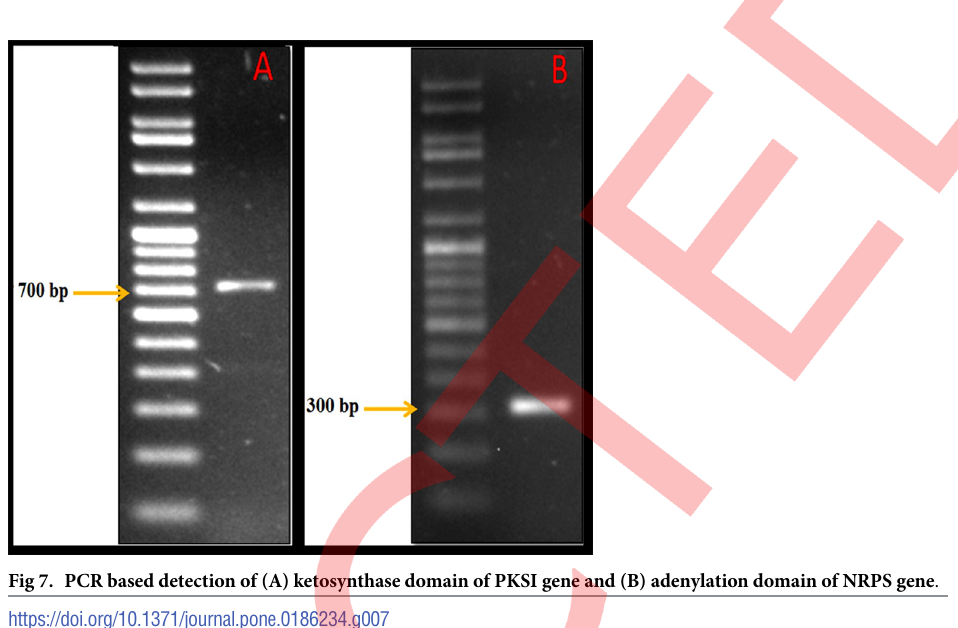
Fig 7. PCR based detection of (A) ketosynthase domain of PKSI gene and (B) adenylation domain of NRPS gene .